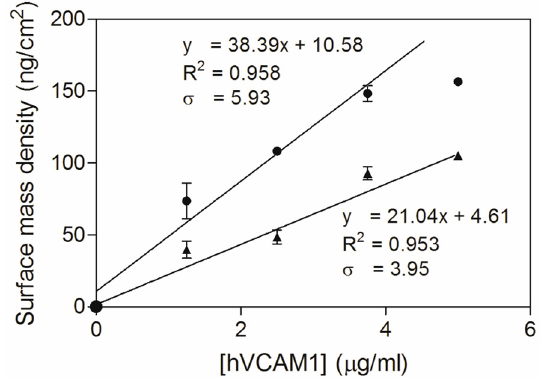
Figure 4. Dose–response curves for the hVCAM1 (R & D Systems) binding to NbVCAM1-LEY-alkyne ( ● ) and rNbVCAM1-His 6 -alkyne ( ▲ ) conjugated silicon slides obtained by ellipsometry. The data were analyzed by means of a linear least squares fitting (95% confidence level; note that only the non-saturating antigen concentrations (0–3.75 μ g/mL) were taken into account for NbVCAM1-LEY-alkyne conjugated surfaces).